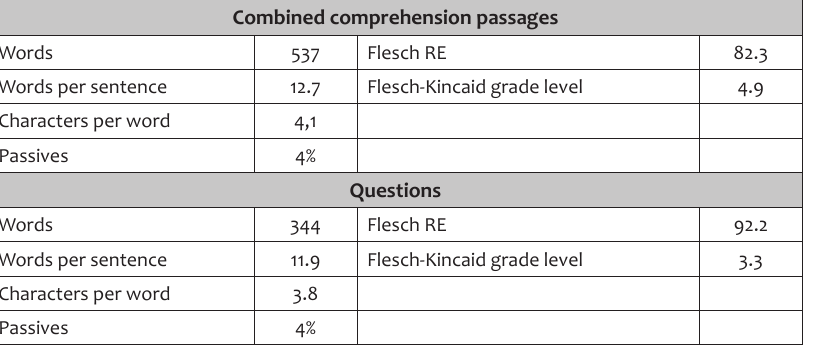
Table 4: Readability score of combined comprehension passages and